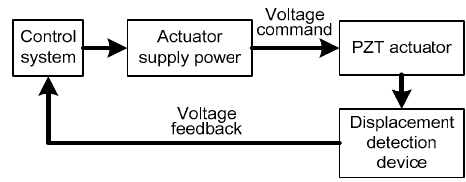
Figure 22. The control system to drive diagram in voltage mode.